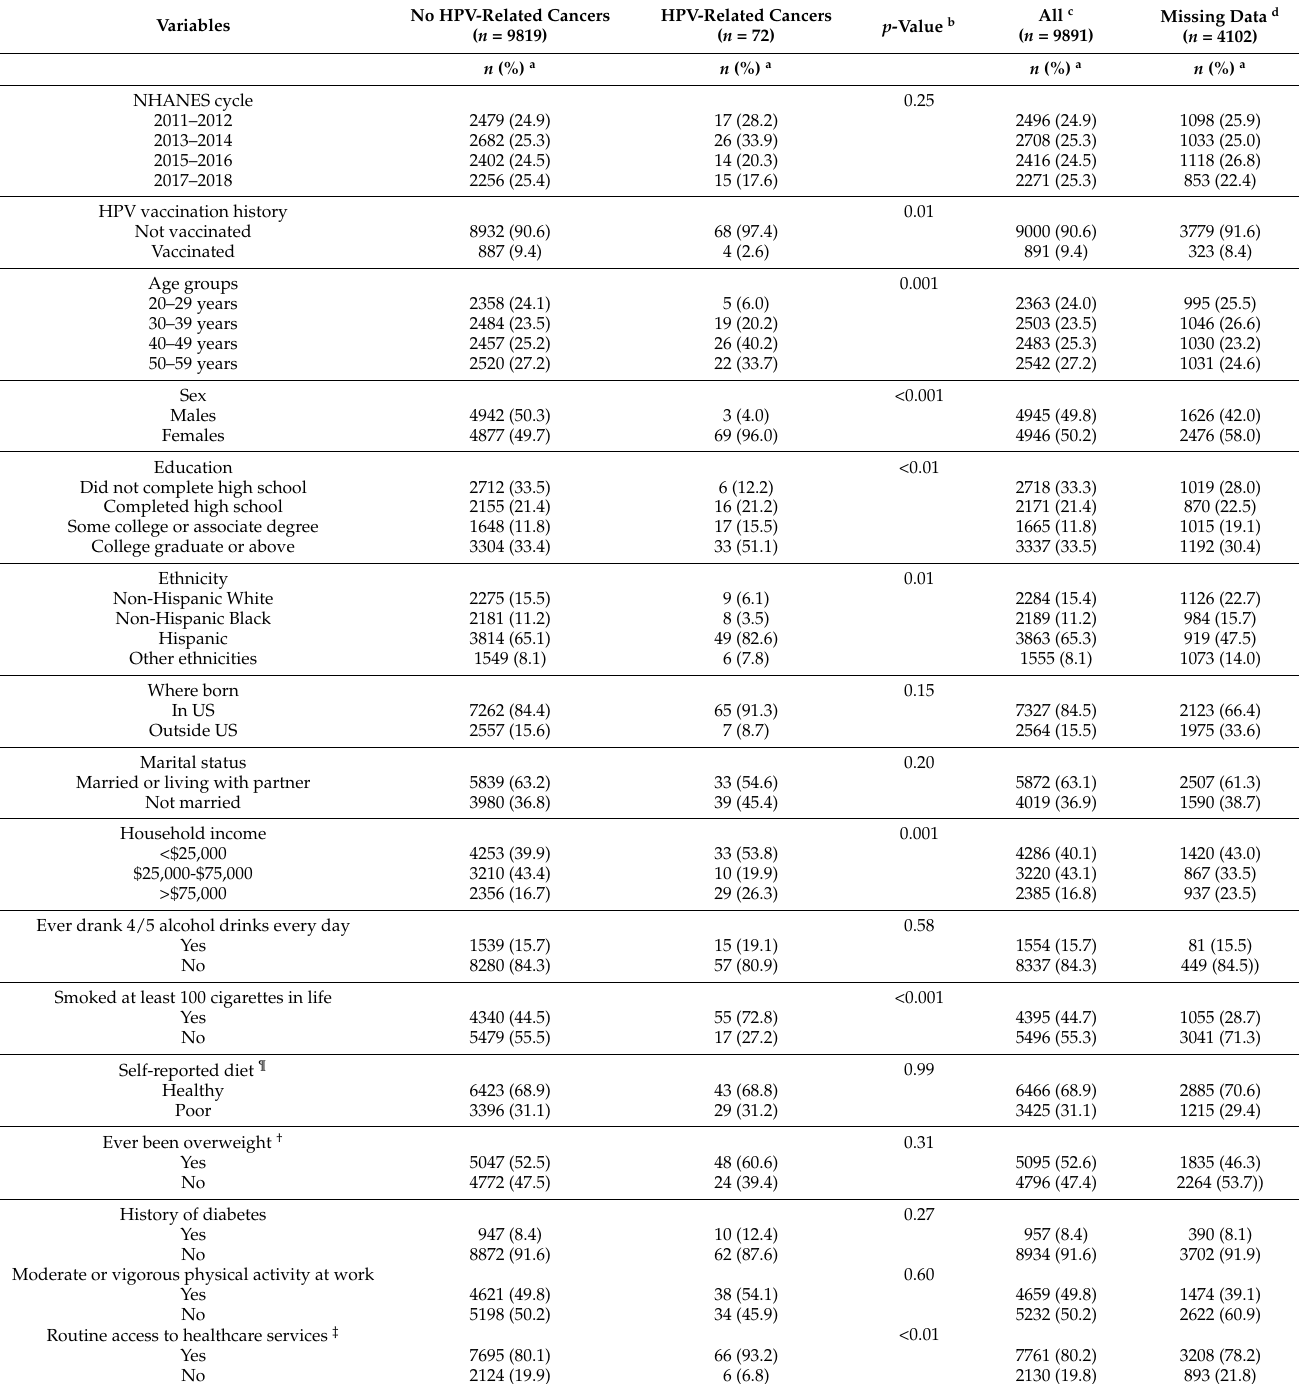
Table 1. Descriptive characteristics of U.S. adults aged 20–59 years, stratified by those who were diagnosed with HPV-related cancers and those who were not diagnosed with HPV-related cancers, using data from the National Health and Nutrition Examination Survey (NHANES),